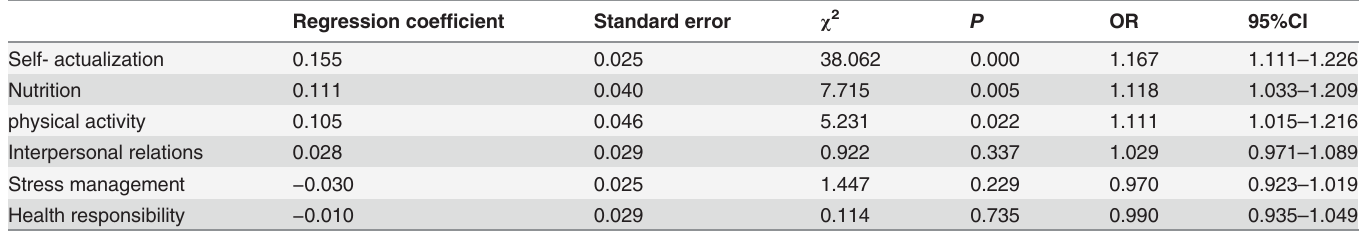
Table 4. Logistic regression analysis of lifestyles and